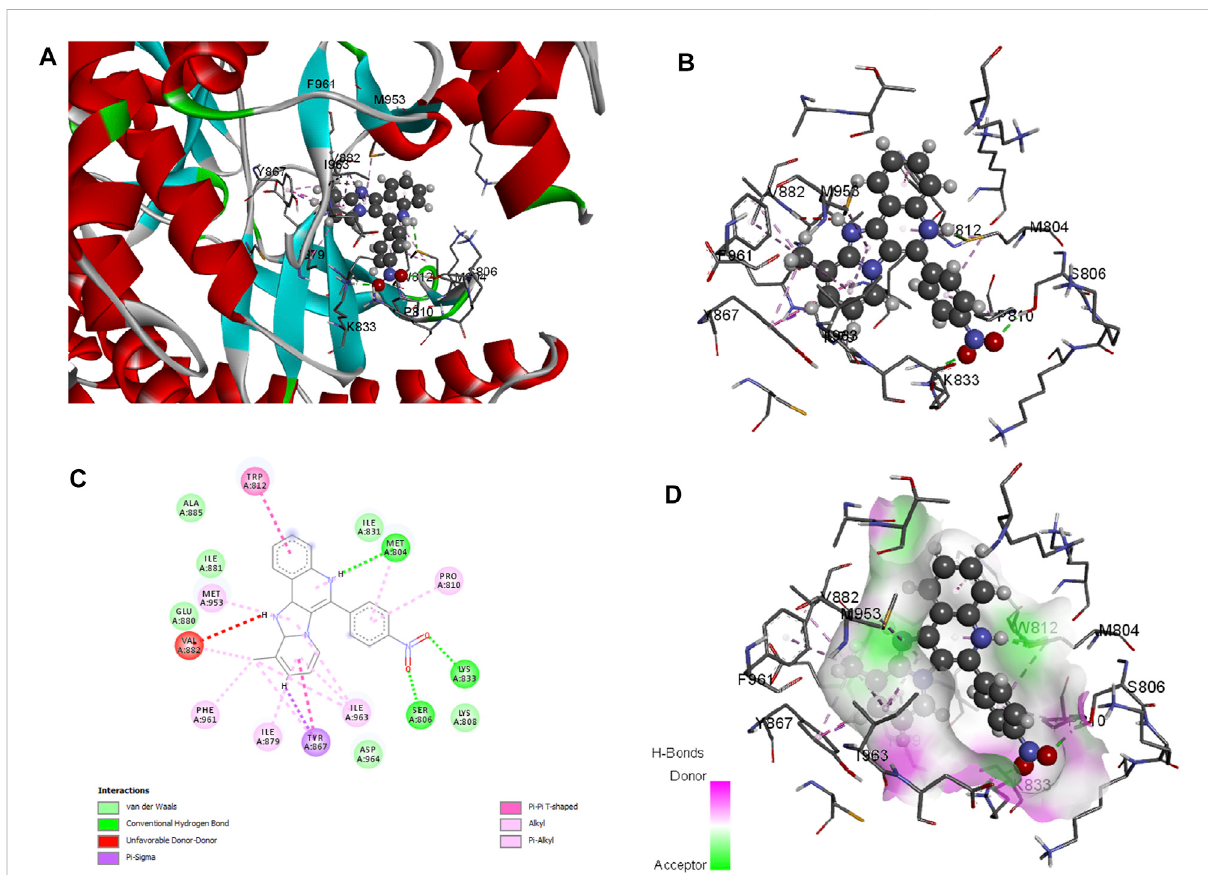
FIGURE 4 Docked conformation of compound 1j with crystal structure of phosphoinositide 3-kinase. (Pdb id: 1E7U) is shown. 1j is represented as ball and stick. (A) 3D Ribbon representation of the binding cavity and its interacting residues with 1j. (B) 3D stick representation of the binding cavity and its interacting residues with 1j. (C) 2D representation of the binding cavity residues along with the nature of interactions. (D) Binding cavity highlighting hydrogen bonding interactions with the residues with 1j.